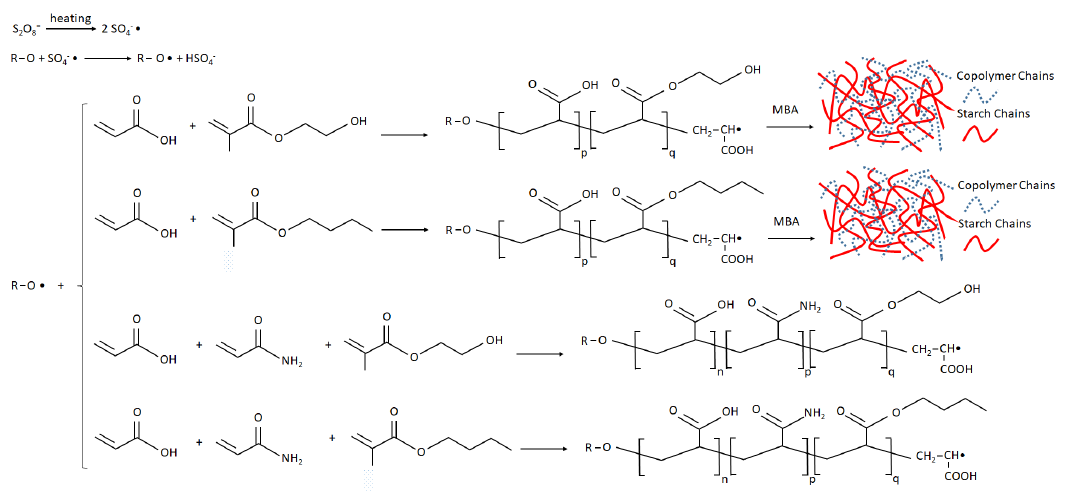
Figure 2. Mechanism of copolymerization of HEMA / AA / MBA, BMA / AA / MBA, HEMA / AA / AAm, and BMA / AA / AAm on starch backbone.